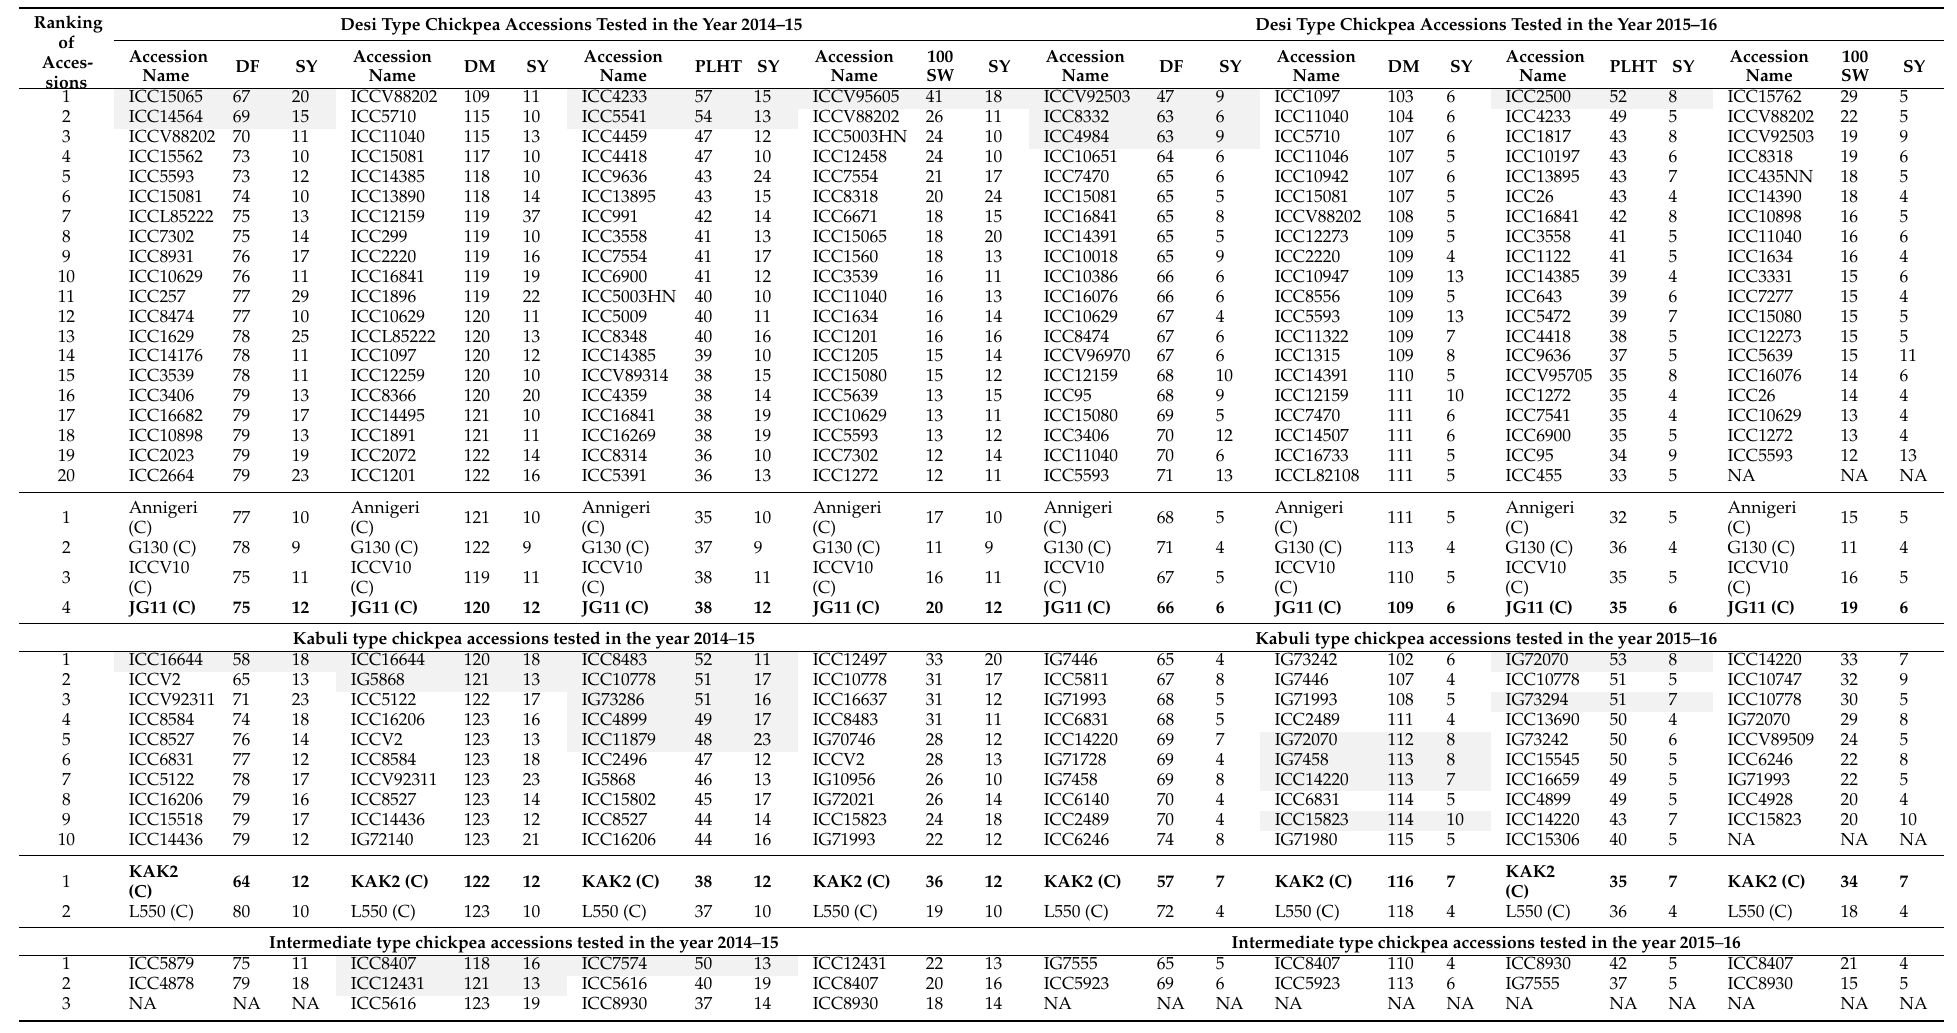
Table 7. Shortlisted germplasm accessions based on ranking biplot for five traits across two years for Sehore, Madhya